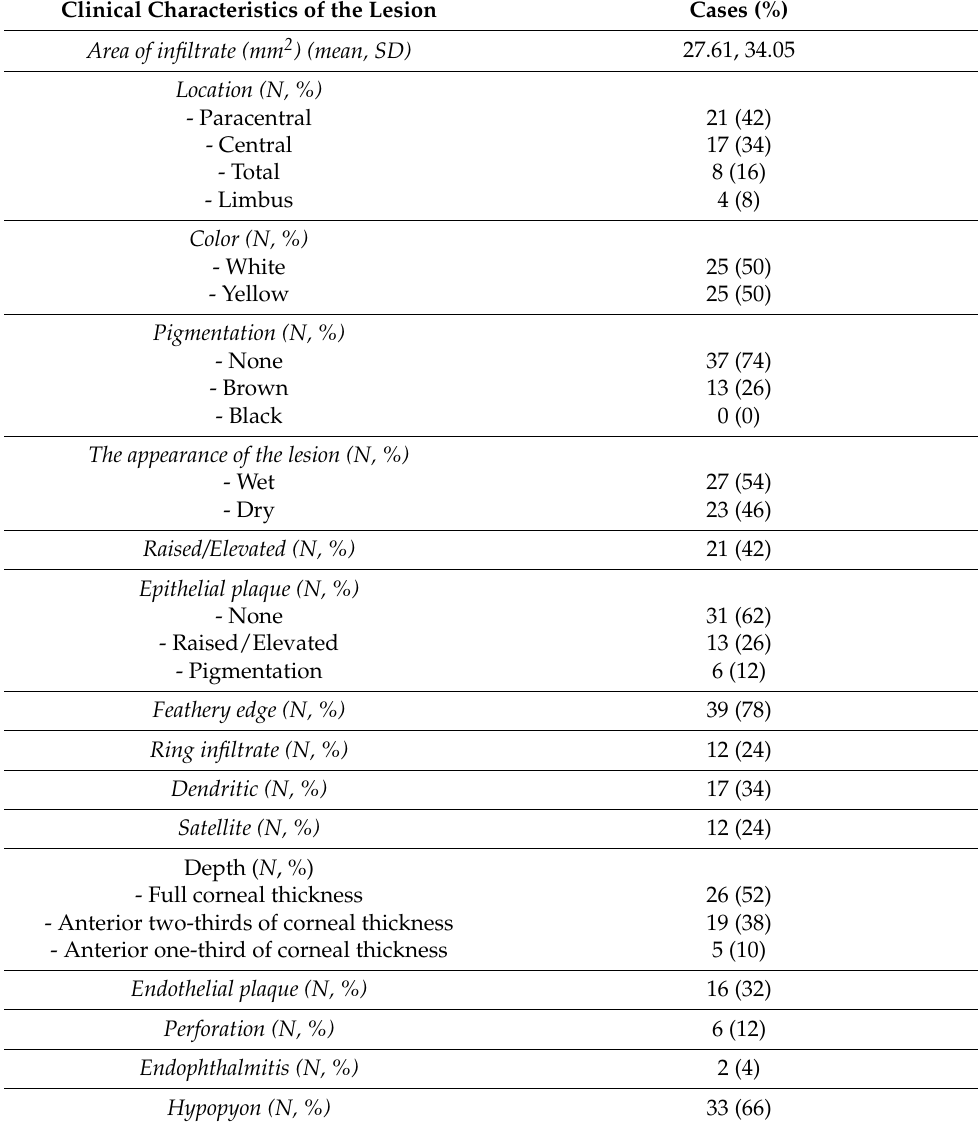
Table 3. Clinical characteristics of dematiaceous fungal keratitis ( N =